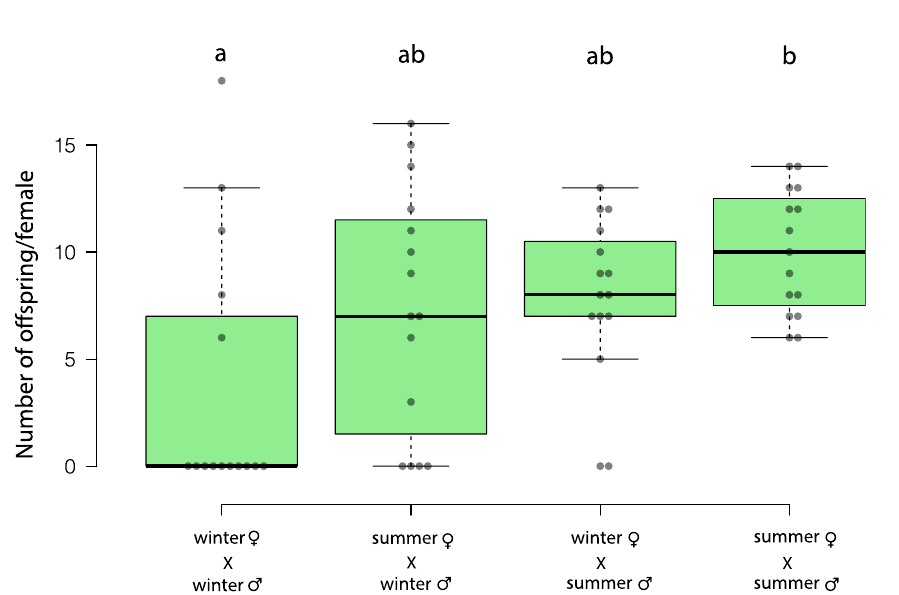
Figure 5. Box plot representing the offspring per female of D. suzukii . Center lines show the medians; box limits indicate the 25th and 75th percentiles, whiskers extend 1.5 times the interquartile range from the 25th and 75th percentiles, n = 15 mating pairs per treatment. All data were analyzed by the Kruskal–Wallis test (H = 10.1; p = 0.02) with post hoc analysis (Dunn’s test); different letters indicate significant differences ( p <